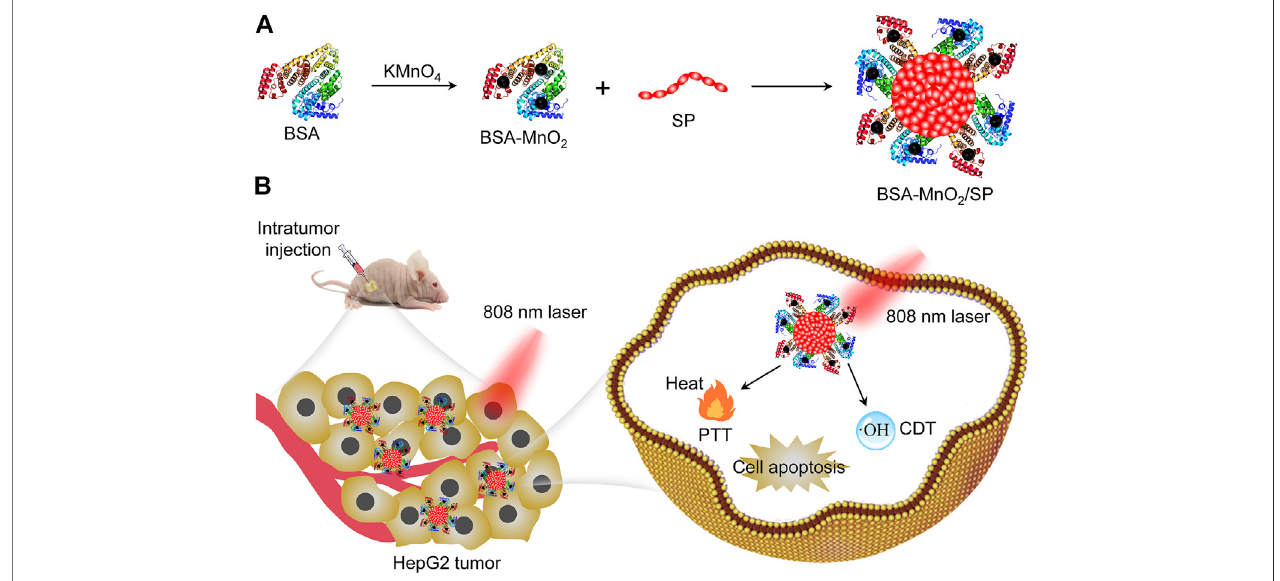
FIGURE1 | Construction ofBSA-MnO 2 /SP nanocomposites for combinational PTTand CDTof hepatic carcinoma. (A) Schematic illustration ofsynthesis ofBSA- MnO 2 /SP nanocomposites. (B) Schematic illustration of BSA-MnO 2 /SP nanocomposite – mediated combinational PTT and